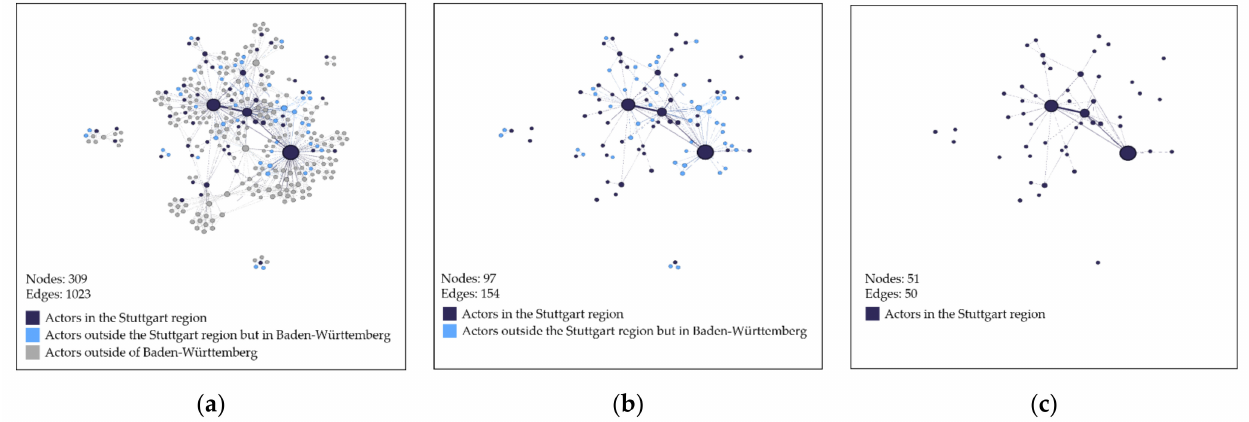
Figure 3. ( a ) Collaboration in bioeconomic projects between actors in the Stuttgart region, in Baden- Württemberg, and outside Baden-Württemberg; ( b ) Collaboration in bioeconomic projects between actors in the Stuttgart region and actors in Baden-Württemberg; ( c ) Collaboration in bioeconomic projects between actors in the Stuttgart region.